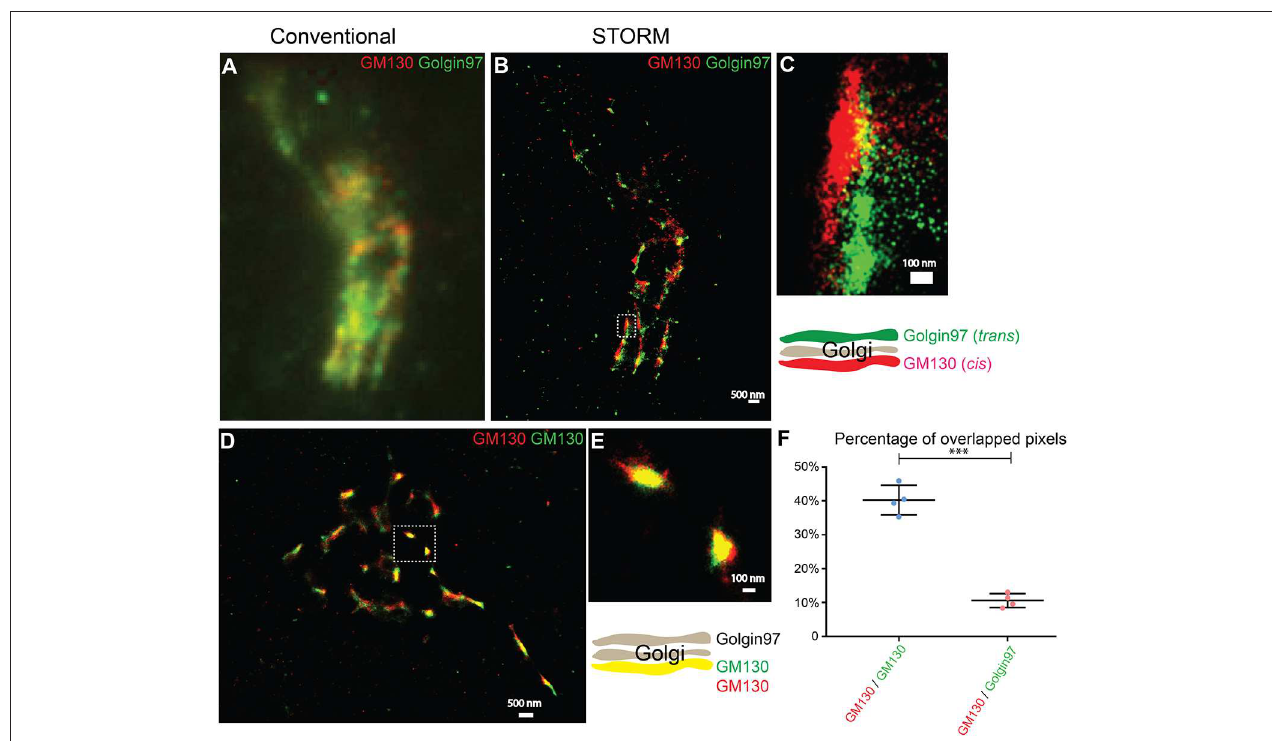
FIGURE 1 | Two-color STORM can be utilized to reveal spatial relationships of Golgi-localized proteins at high resolution. (A,B) Localization patterns of a cis -Golgi marker (GM130) and a trans -Golgi marker (Golgin-97) in the same COS7 cell visualized through conventional fluorescent microscopy (A) or through two-color STORM (B) . Scale bar, 500nm. (C) A magnified view of the indicated area in (B) . Scale bar, 100nm. (D) Localization patterns of a cis -Golgi marker (GM130) labeled with two different fluorescent dyes in the COS7 cell revealed through two-color STORM. Scale bar, 500nm. (E) A magnified view of the indicated area in (D) . Scale bar, 100nm. (F) Quantification of the percentage of overlapped pixels between GM130 and Golgin-97 and between Alexa Fluor 750-labeled GM130 and Alexa Fluor 647-labeled GM130 based on four super-resolution images acquired from one experiment in each experimental group (mean ± SD). *** p < 0.001 by two-tailed Student’s t -test. The super-resolution images showed the localization patterns of the indicated protein in the whole juxtanuclear area. Each dot in the graphs represents data of the whole juxtanuclear Golgi area of each individual